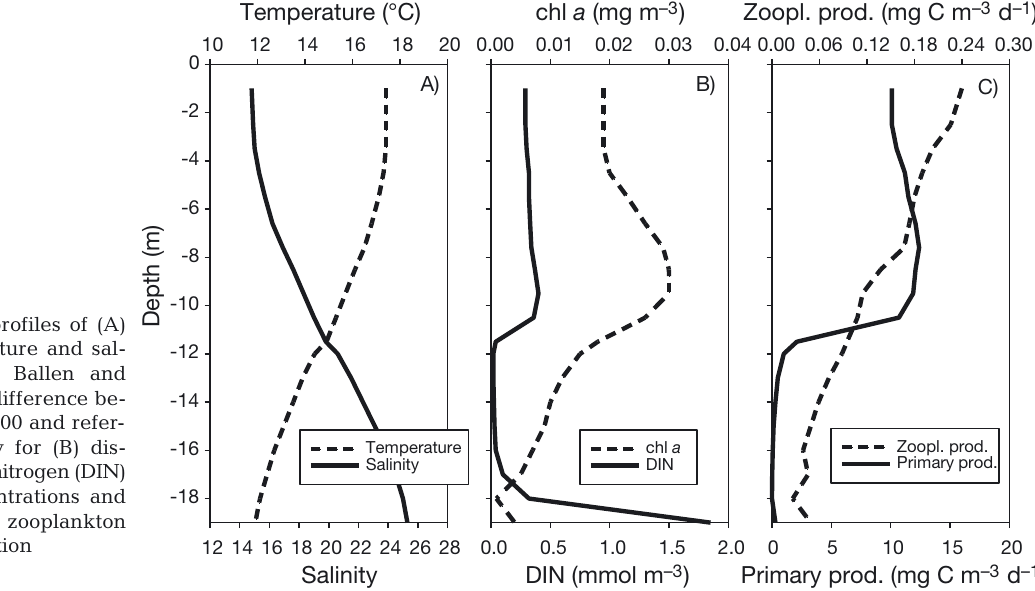
Fig. 7. Vertical profiles of (A) average temperature and sal - inity in July at Ballen and (B,C) maximum difference be- tween Scenario 100 and refer- ence run in July for (B) dis- solved inorganic nitrogen (DIN) and chl a concentra tions and (C) primary and zooplankton